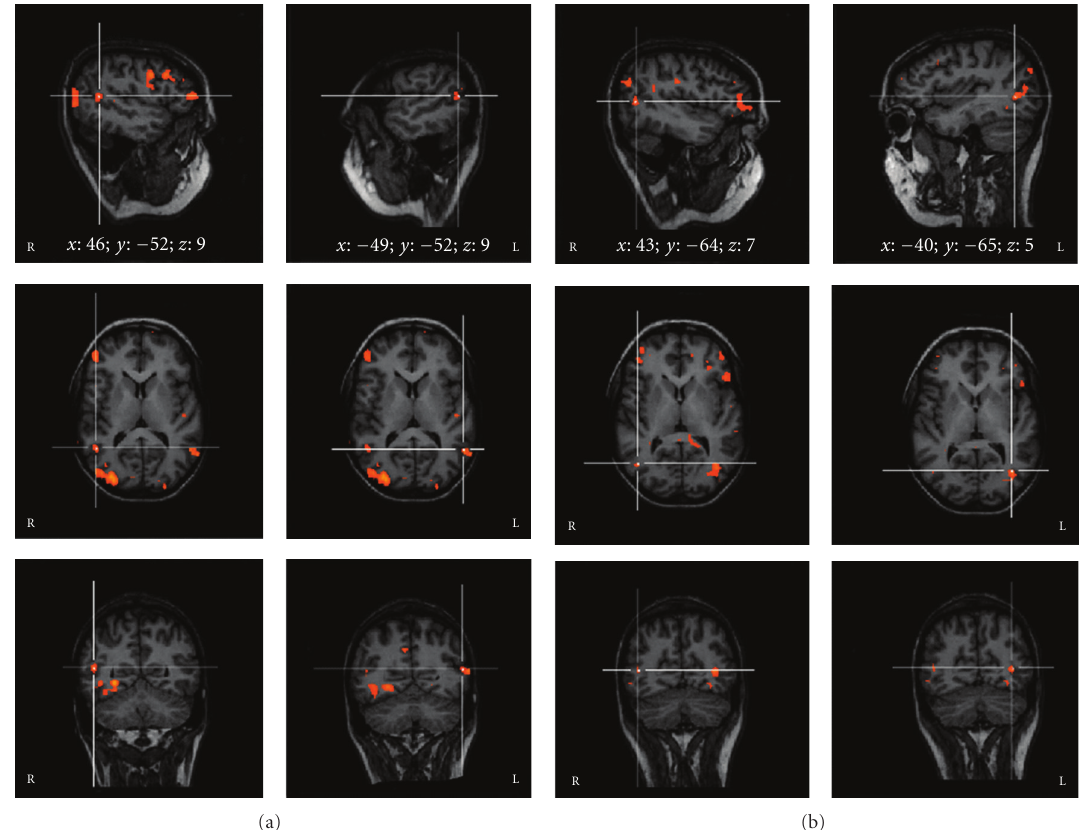
Figure 3: Activation foci evoked by stimulation of the una ff ected (a) and a ff ected (b) eye in a patient with acute left optic neuritis. White lines show activation in area MT/V5 in right and left hemispheres. The Talairach coordinates ( x ; y ; z ) of the activated area are also reported. L and R: left and right.